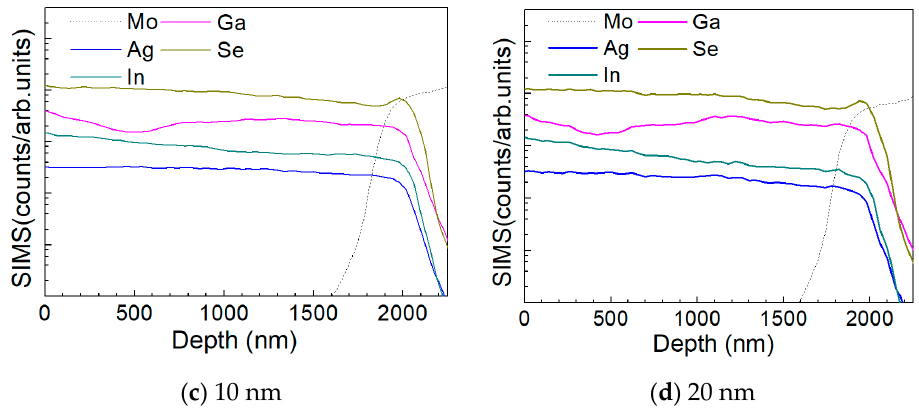
Figure 10. Elemental distribution profiles of AIGS films as a function of Na 2 Se thickness by secondary ion mass spectroscopy (SIMS): ( a ) 0, ( b ) 5, ( c ) 10, and ( d ) 20 nm.